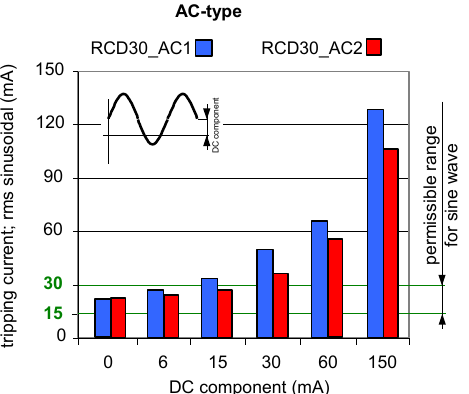
Figure 12. Tripping current (rms value of the AC sinusoidal component) of two 30 mA AC-type RCDs under AC sinusoidal current superimposed by smooth DC component of values 6, 15, 30, 60, and 150 mA.